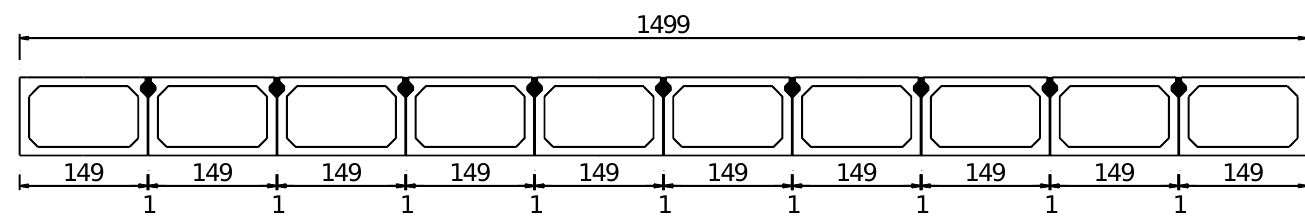
Figure 7. Transverse layout of the bridge (cm).